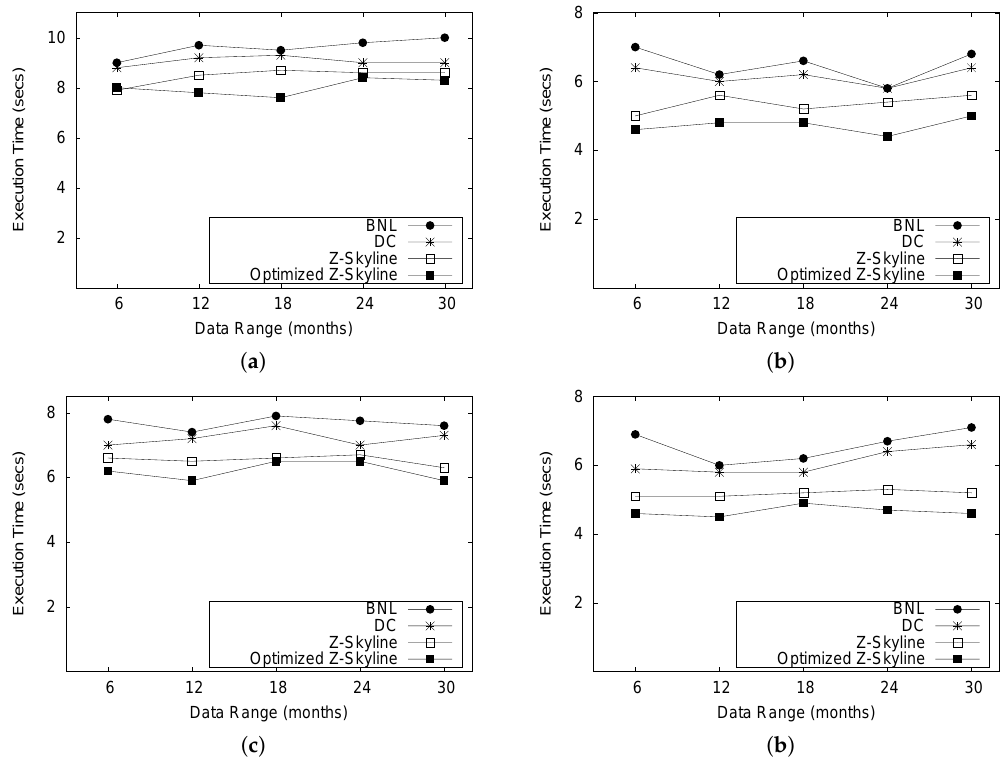
Figure 27. Profitable-area query performance by data range. ( a ) Rush Hour, NewYork ; ( b ) Normal, NewYork ; ( c ) Rush Hour, Chicago ; ( b ) Normal, Chicago .